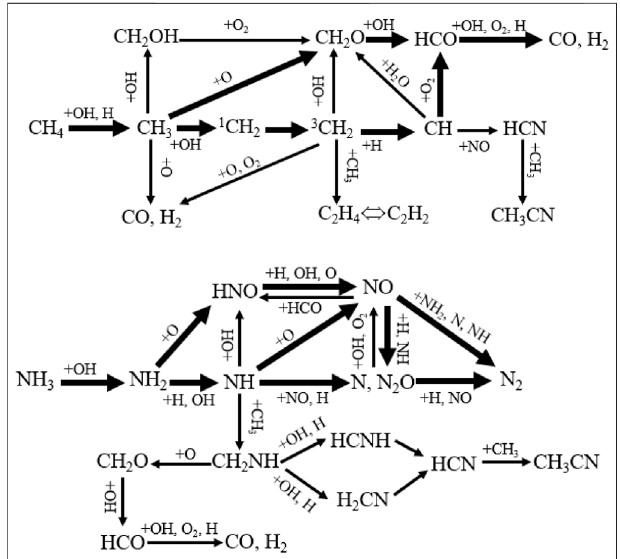
FIGURE 10 | Diagram of ammonia/methane mixture oxidation pathway, replotted from (Tian et al.,